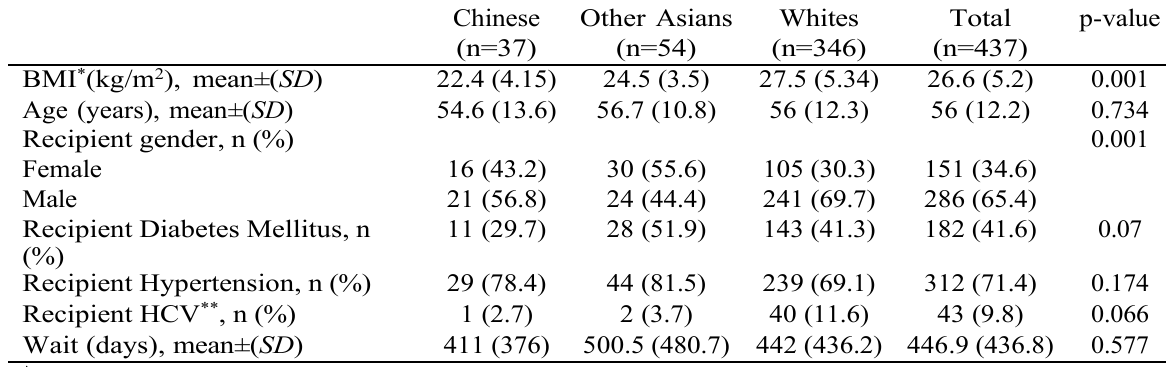
Table 2: Demographic